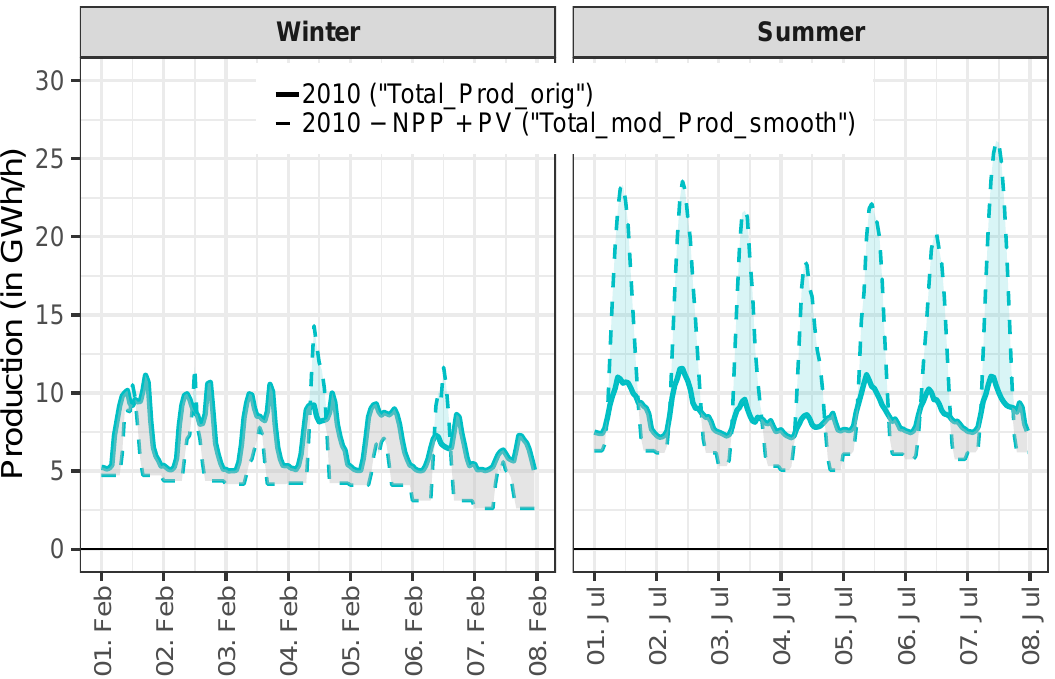
Figure 18. ( Left ): Hourly Swiss electricity production for 2010 in the original profile of Swissgrid (“Total_Prod_orig” in Table 1) with nuclear power plants (NPP). ( Right ): Modified profile with a complete substitution of NPP by PV (“Total_mod_Prod_smooth” in Table 1). Labels are the seasonal and annual sums.